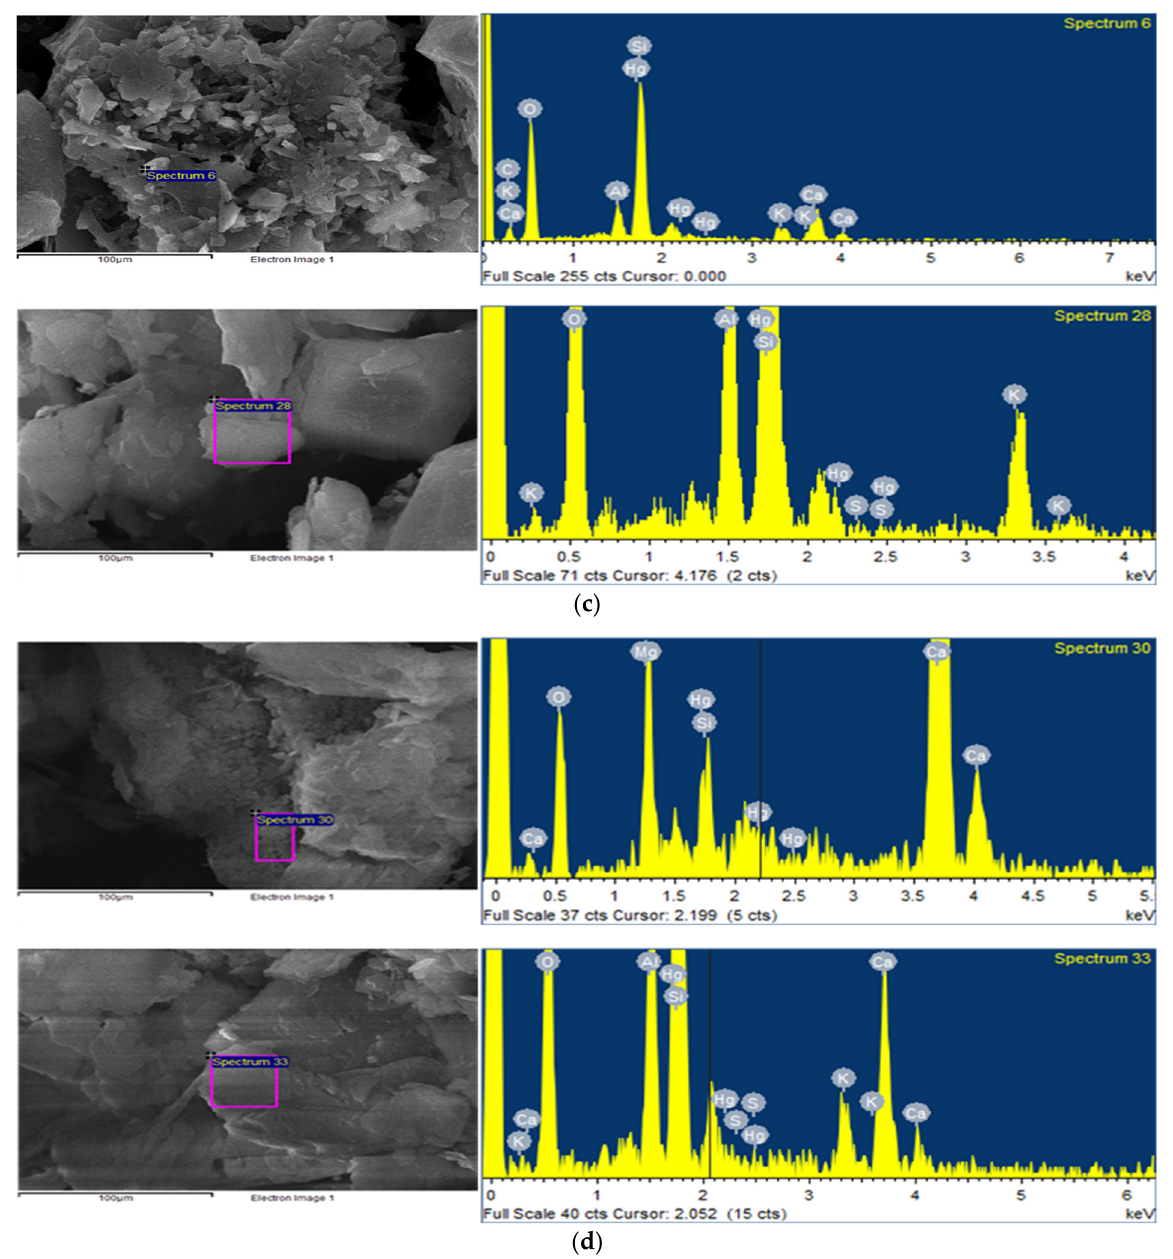
Figure 9. SEM-EDX analyses for the Hg in contaminated soil treated with 10 wt% ASF (-#10 mesh) ( a ), 10 wt% PSF (-#10 mesh) ( b ), 5 wt% CASF (-#10 mesh) ( c ), and 5 wt% CPSF (-#10 mesh) ( d ) treated